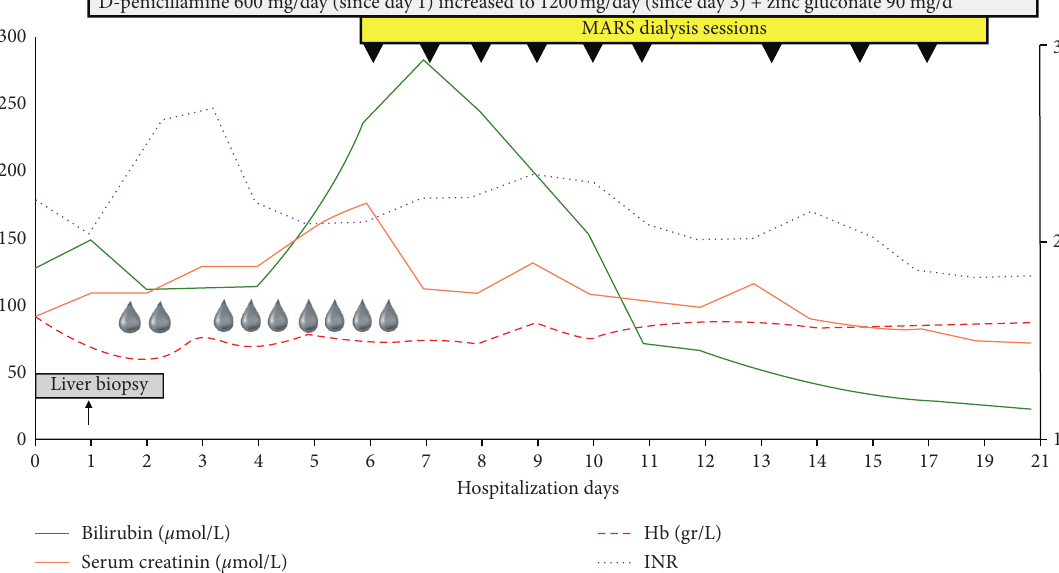
Figure 1: Liver biopsy specimen. (a) Annular fibrosis (AF) surrounding hepatocyte nodules (Masson trichrome staining, original magnification × 50). (b) Chronic hepatitis with lobular activity (open arrow), ballooned hepatocytes (black arrows), and mild steatosis (H&E staining, original magnification × 50). (c) Black arrows indicate Victoria blue staining deposits in periportal areas. D-Penicillamine 600 mg/day (since day 1) increased to 1200 mg /day(since day 3) + zinc gluconate 90 mg/dD-penicillamine 600 mg/day (since day 1) increased to 1200mg/day (since day 3) + zinc gluconate 90 mg/d